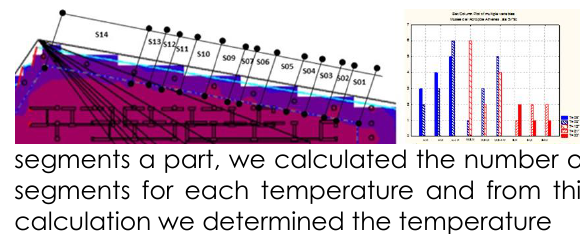
Figure 1: Schematic segmentation, and graph of number of segments by temperature (source: author,